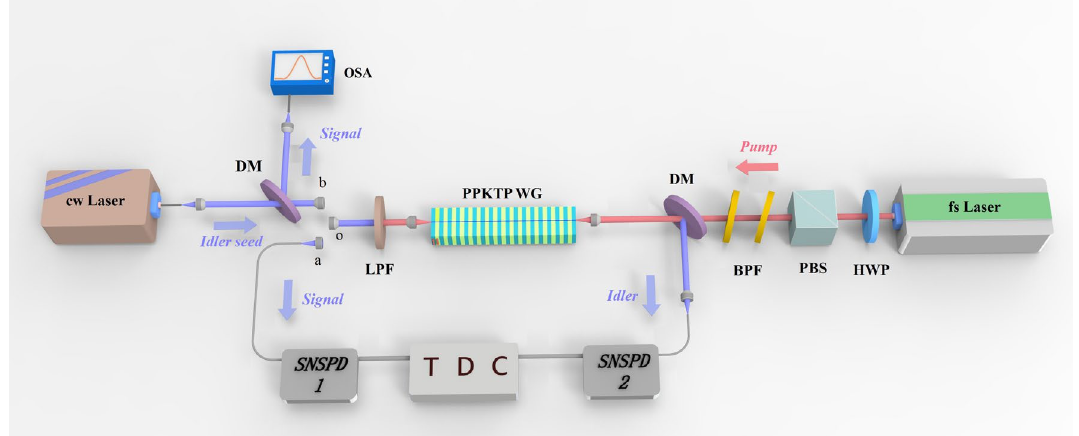
Figure 2. Experimental setup. HWP half-wave plate, PBS polarizing beam splitter, DM dichroic mirror, BPF band-pass filter, LPF long pass filter, SNSPD nanowire superconducting detector, TDC time-to-digital